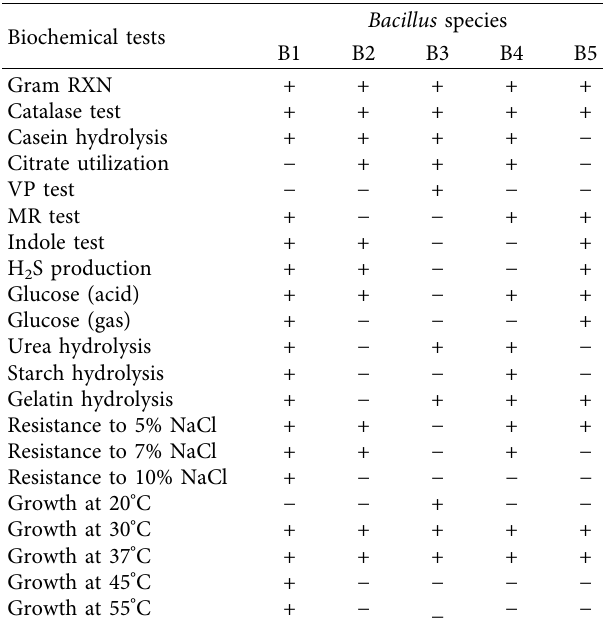
Table 2: Physiological and biochemical characteristics of Bacillus